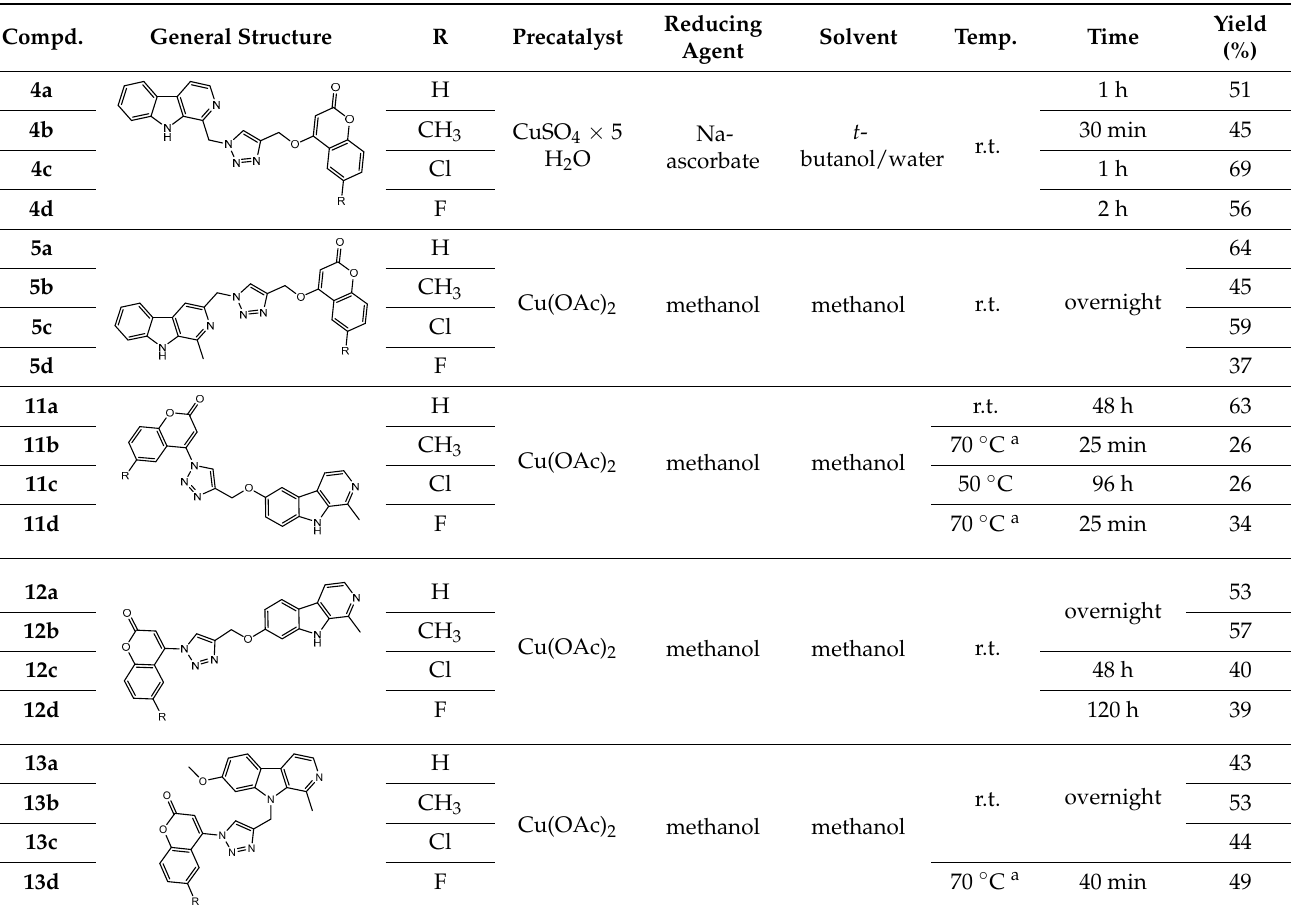
Table 1. The reaction conditions for the synthesis of harmirins and obtained yields. Table 1 . The reaction conditions for the synthesis of harmirins and obtained yields. Table 1 . The reaction conditions for the synthesis of harmirins and obtained yields. Table 1 . The reaction conditions for the synthesis of harmirins and obtained yields. Table 1 . The reaction conditions for the synthesis of harmirins and obtained yields. Table 1 . The reaction conditions for the synthesis of harmirins and obtained yields. Compd. Compd. Compd. Compd. Compd.